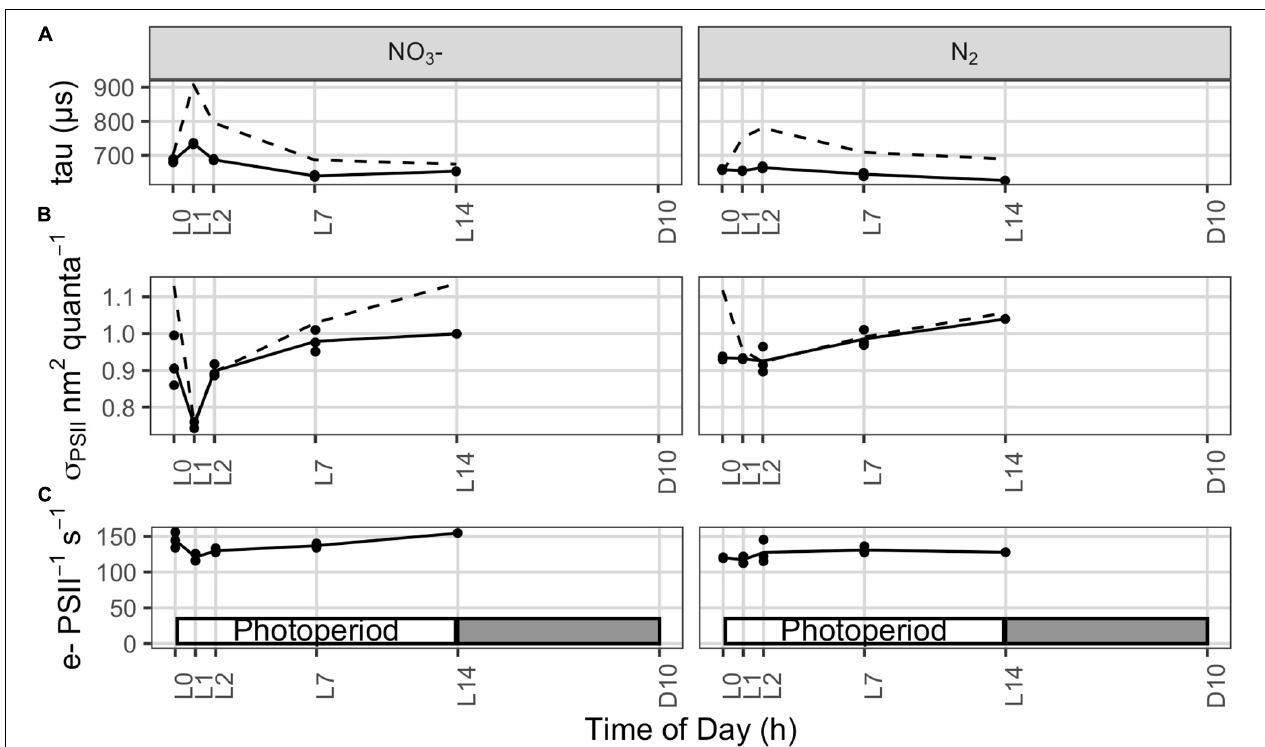
FIGURE 4 | (A) Lifetime for re-opening of Photosystem II, τ ( µ s), reflecting capacity for transport of electrons away from PSII, measured using FRRf relaxation after a single turnover saturating flash, applied on top of actinic illumination ( τ (cid:48) , solid lines), similar to the growth light level of 300 µ mol photons m − 2 s − 1 in the photobioreactors. Dashed lines show the average of τ measures taken from the same samples in darkness. (B) Effective absorption cross section for Photosystem II measured using FRRf under growth illumination (solid lines; σ PSII (cid:48) , nm 2 quanta − 1 ) or under darkness (dashed lines; σ PSII , nm 2 quanta − 1 ). (C) Photosystem II electron transport (e − PSII − 1 s − 1 ) under growth illumination estimated from FRRf parameters, following